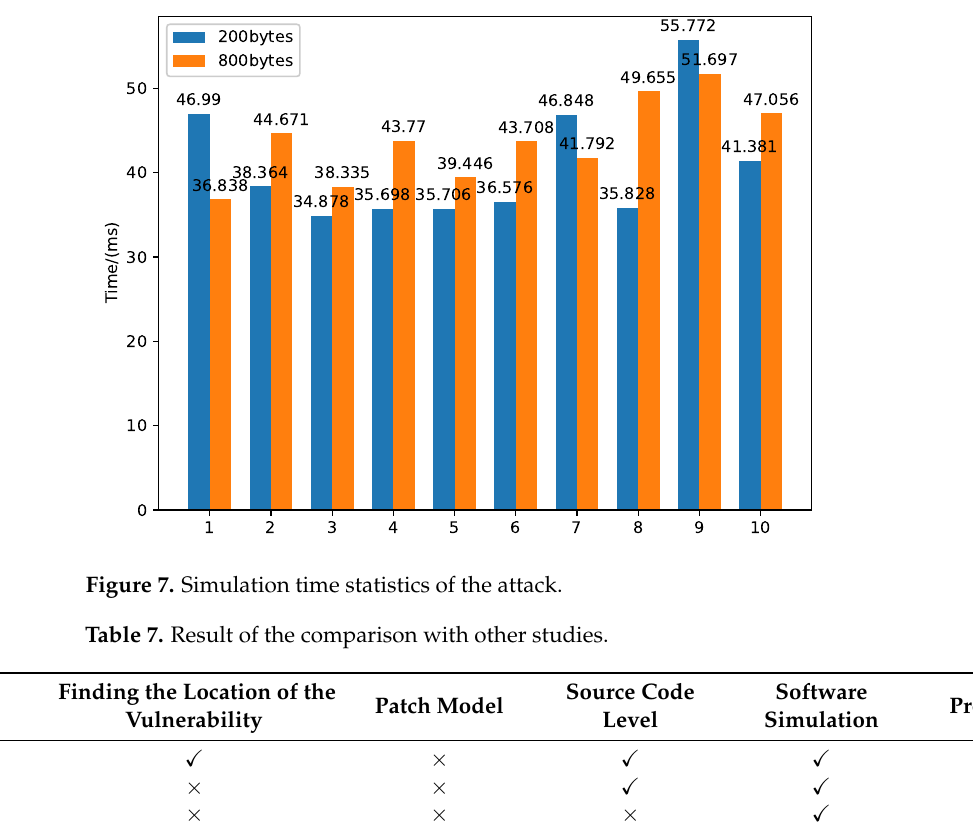
Figure 6. Simulation time statistics of the model.